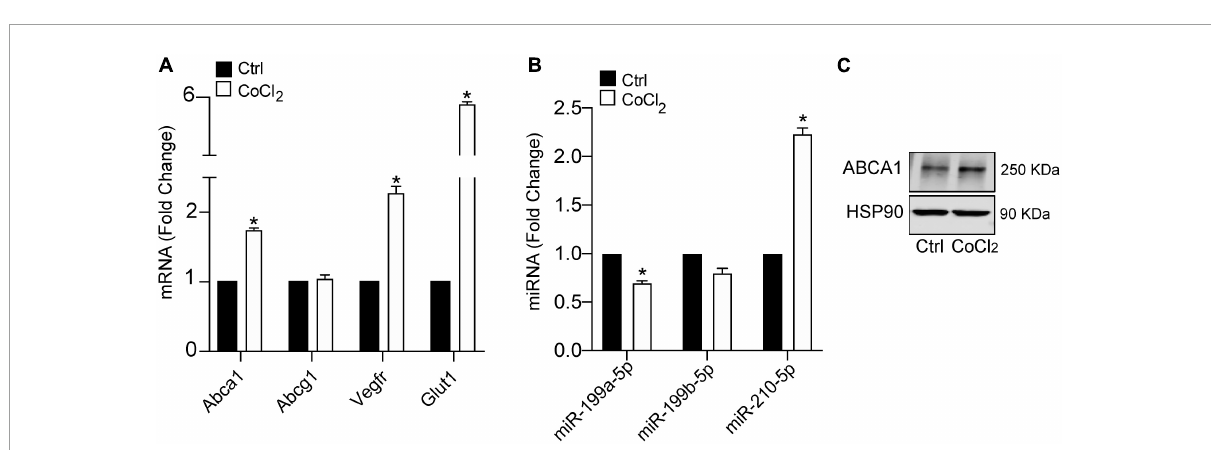
FIGURE3 Hypoxia mimicking condition dowregulates miR-199a-5p expression. (A) qRT-PCR analysis of miR-199a-5p, miR-199b-5p, and miR-210-5p mouse peritoneal macrophages stimulated with CoCl 2 (100 µ M) that mimics hypoxia conditions. (B) qRT-PCR analysis Abca1, Hif α , Vegfr, and Glut-1 expression levels in was used as a positive control for hypoxia. (C) Representative Western Blot analysis of ABCA1 in mouse peritoneal macrophages stimulated with CoCl 2 (100 µ M) for 24 h. HSP90 was used as a loading control. Data are expressed as relative expression levels and correspond to the means ± SEM from three independent experiments performed in triplicate. * P < 0.05, significantly different from control (Ctrl) non-treated